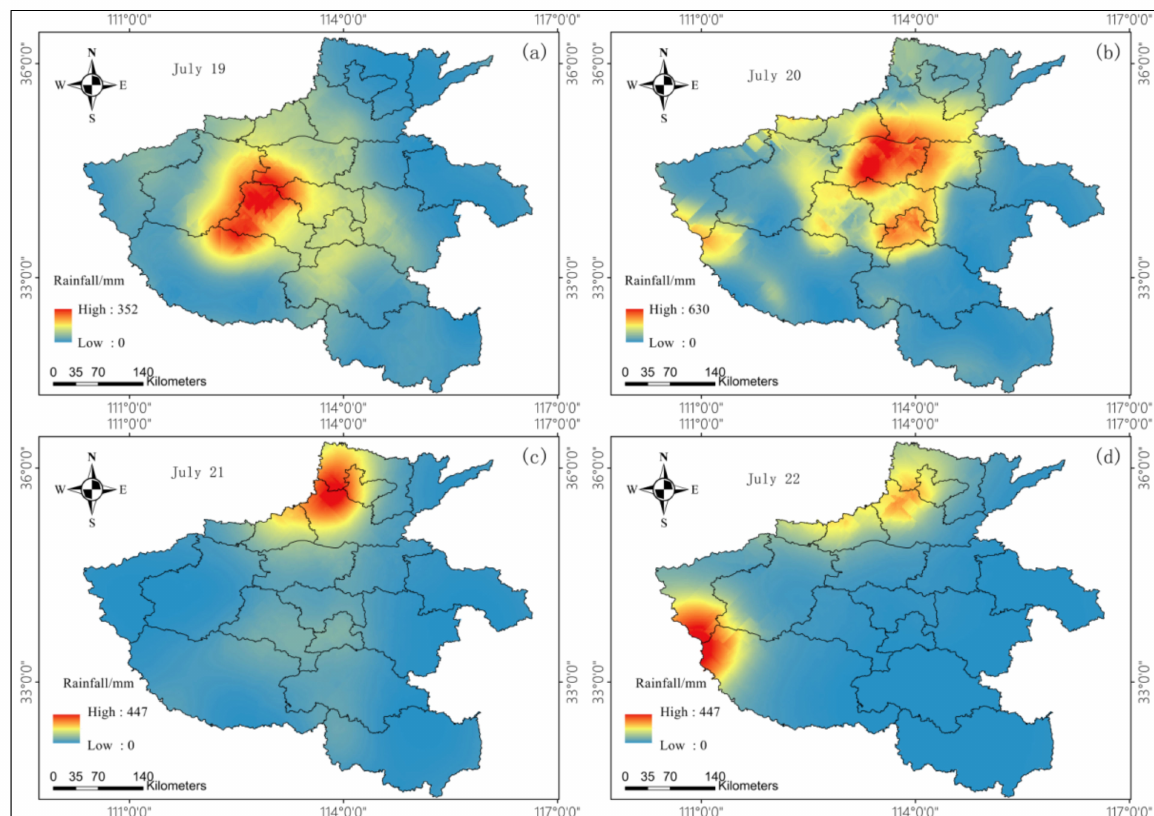
Figure 4. Inversion of rainfall development distribution in Henan Province from July 19 to July 22: ( a ) Rainfall development and distribution on July 19 in Henan Province; ( b ) Rainfall development and distribution on July 20 in Henan Province; ( c ) Rainfall development and distribution on July 21 in Henan Province; ( d ) Rainfall development and distribution on July 22 in Henan